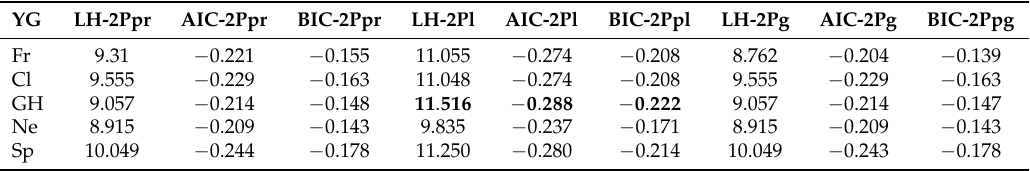
Table 8. Loglikelihood, AIC and BIC values for the young generation, 2P-copulas.